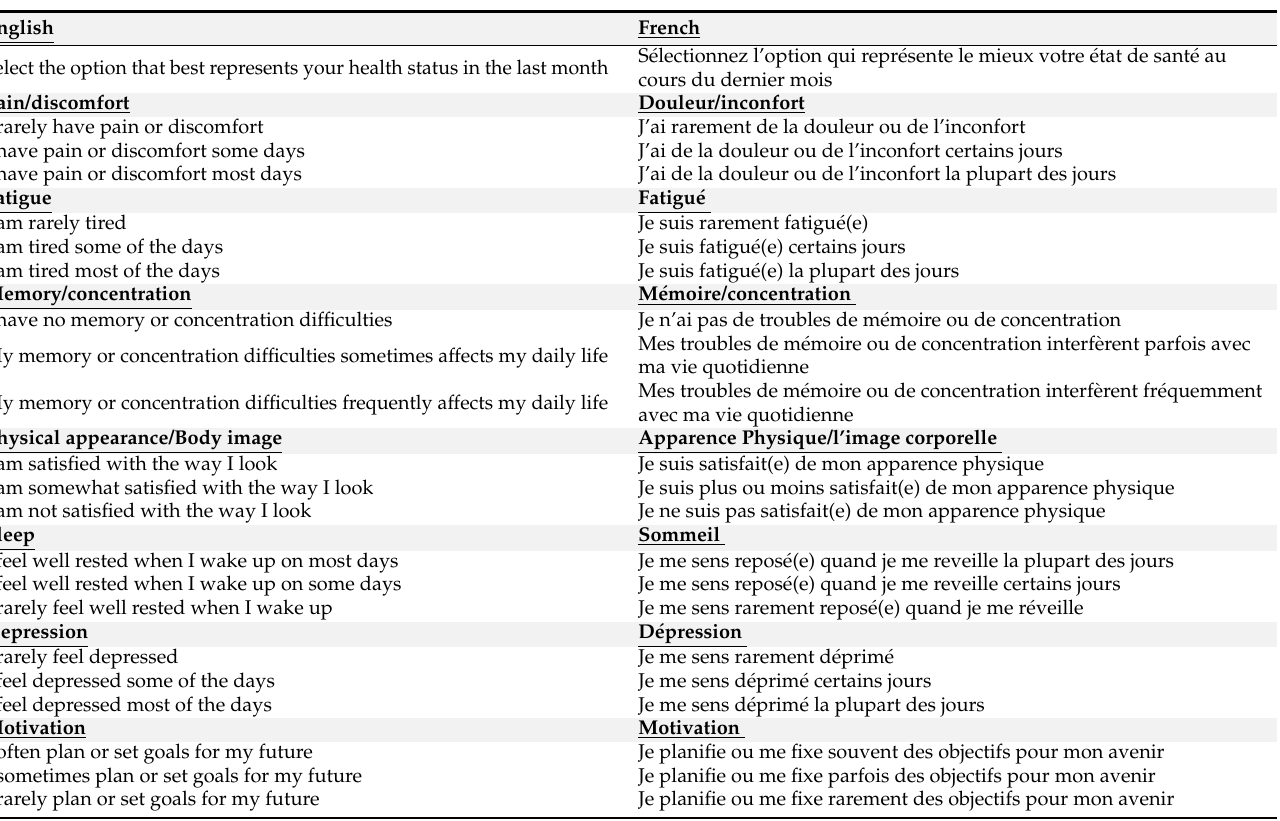
Table 8. PB-HIV Index with seven dimensions with three declarative statements in English and